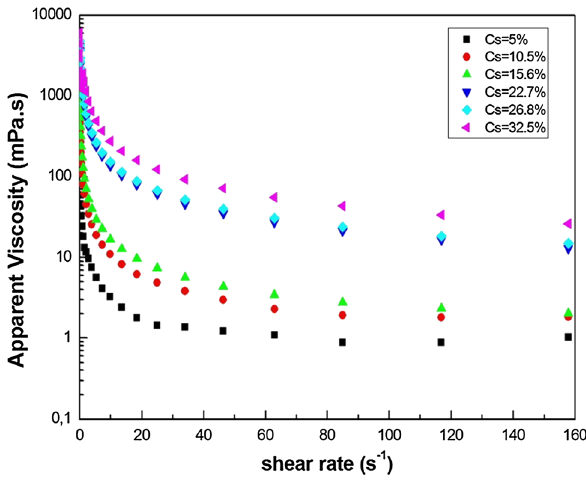
Fig. 7 Apparent viscosity as a function of shear rate at different solids